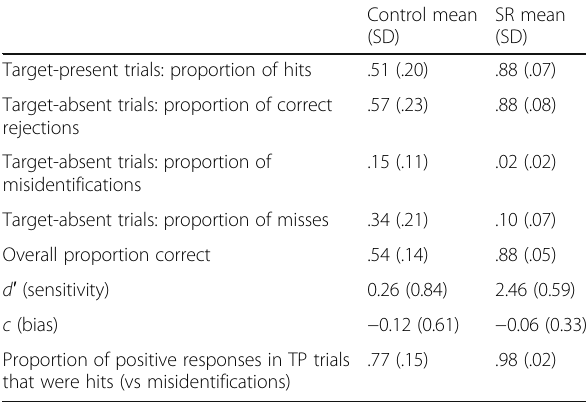
Table 2 Breakdown of performance on the models